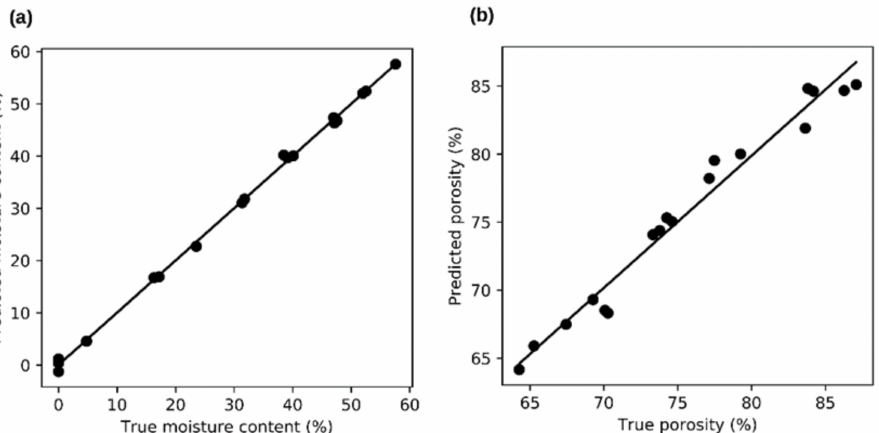
Figure 8. Examples of relationships between real data and predicted data. Plotted data for forest wood chips without logarithmic adjustment. ( a )—linear model for moisture content, R 2 = 0.997. ( b )—linear model for porosity, R 2 =